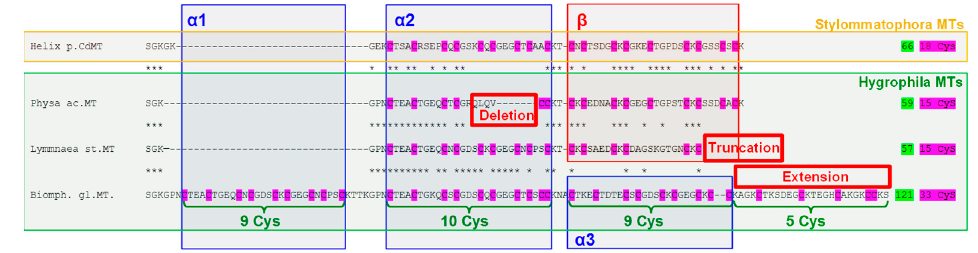
Figure 8. Sequence Alignment of sequences of various snail MTs: Alignment of Helix pomatia CdMT (Helix p.CdMT) ( Stylommatophora MTs, orange -framed box) sequence with those of MTs of Hygrophila ( Hygrophila MTs, green -framed box), including MTs of Physa acuta (Physa ac.MT), Lymnaea stagnalis MT (Lymnaea st.MT) and Biomphalaria glabrata MT (Biomph. gl.MT), showing the presumed domain organization with up to three α domains ( α 1, α 2 and α 3, blue -framed boxes) and one β domain ( red -framed box). Conserved cysteine positions in the MT sequences are underlaid in pink. Also indicated in green letters are the numbers of Cys residues in every single domain of the Biomphalaria gl. MT, along with primary structure deviations (Deletion, Truncation, Extension) in Hygrophila MTs from the Helix pomatia CdMT model. Identical amino acid residues between the aligned sequences are indicated by stars. The respective amino acid chain lengths of the MT peptides are highlighted in green near their C-terminal ends. Also indicated next to the C-termini are the numbers of Cys residues in each MT sequence (underlaid in pink). GenBank Accession numbers of the shown sequences are as follows: Helix pomatia CdMT, ACN66299.1; Physa acuta MT, GU259686; Lymnaea stagnalis MT, KT253648; Biomphalaria glabrata MT KT697617.